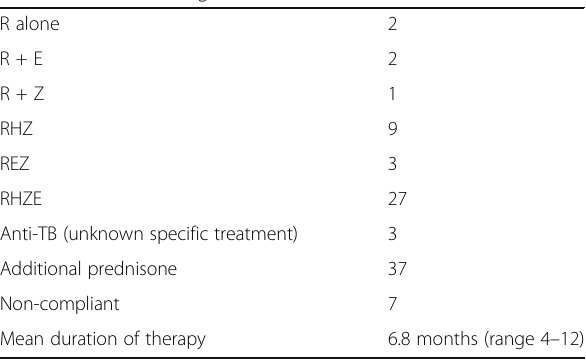
Table 3 Treatment